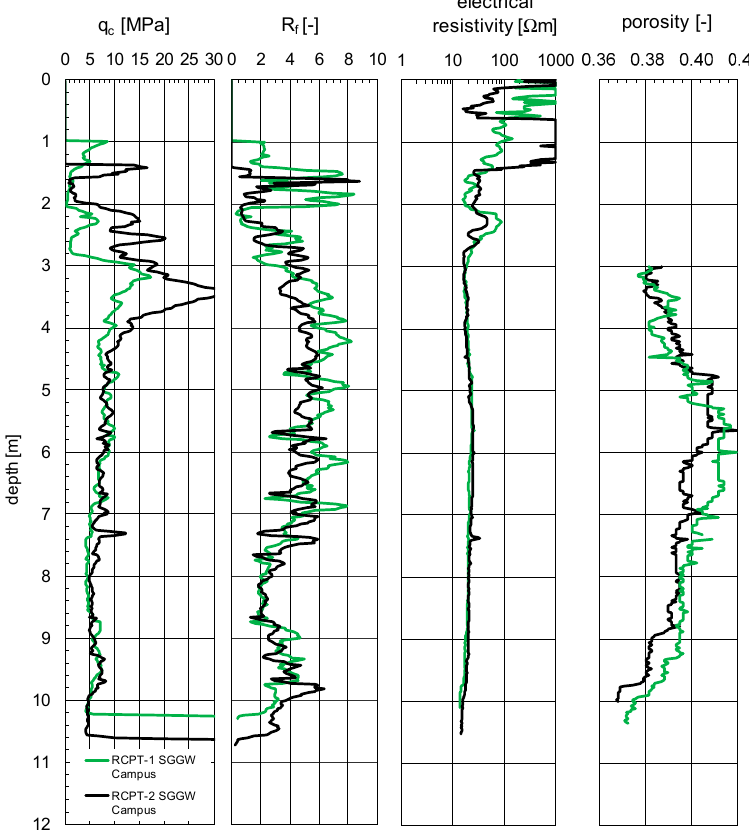
Figure 12. Results of RCPT tests; electrical resistivity of sands with calculated porosity of sandy clay.